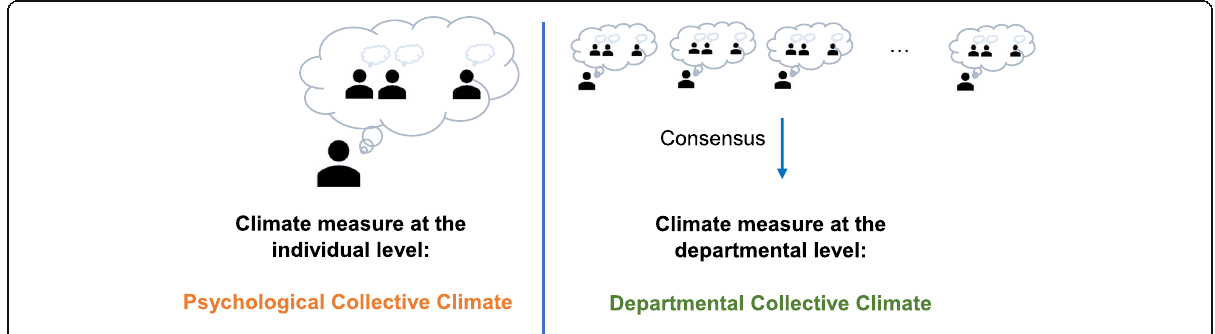
Fig. 1 Difference between psychological collective climate and departmental collective